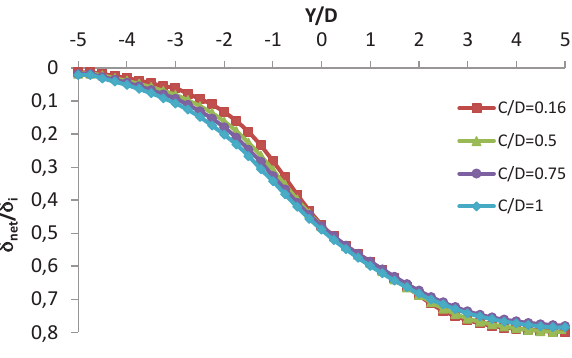
soil. The settlement is small for both soils until reaching Y/D = -2. After reaching Y/D = -2 the Fig. 15 Distributions of normalized net pile head settlement with tunnel advancement for various C/D Figure 15: Distributions of normalized net pile head settlement with settlement of soil 2 becomes larger than soil 1 but in both soils the settlement almost stabilized to a (group of piles). Analysis series (XV, XVI, XVII, and XVIII) tunnel advancement for various C/D (group of piles). Analysis series constant value of Y/D = +2.